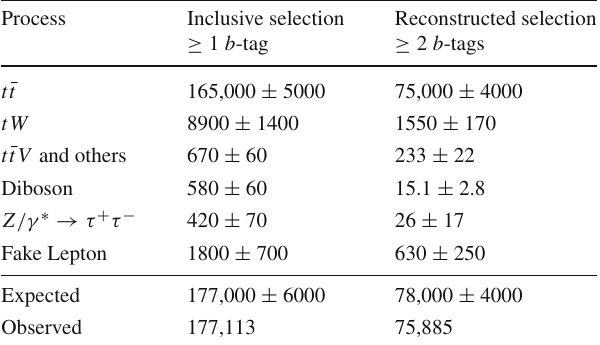
Table 1 Event yields in the inclusive and reconstructed selections for theobserveddata,expectedsignalandexpectedbackground.Theuncer- tainties quoted include contributions from leptons, jets, missing trans- verse momentum, luminosity, background modelling, and pile-up mod- elling. They do not include uncertainties from PDF or signal t ¯ t mod- elling. The “ t ¯ tV and others” entries contain events from t ¯ tZ , t ¯ tW , t ¯ tWW , t ¯ tH , and the t ¯ tt ¯ t